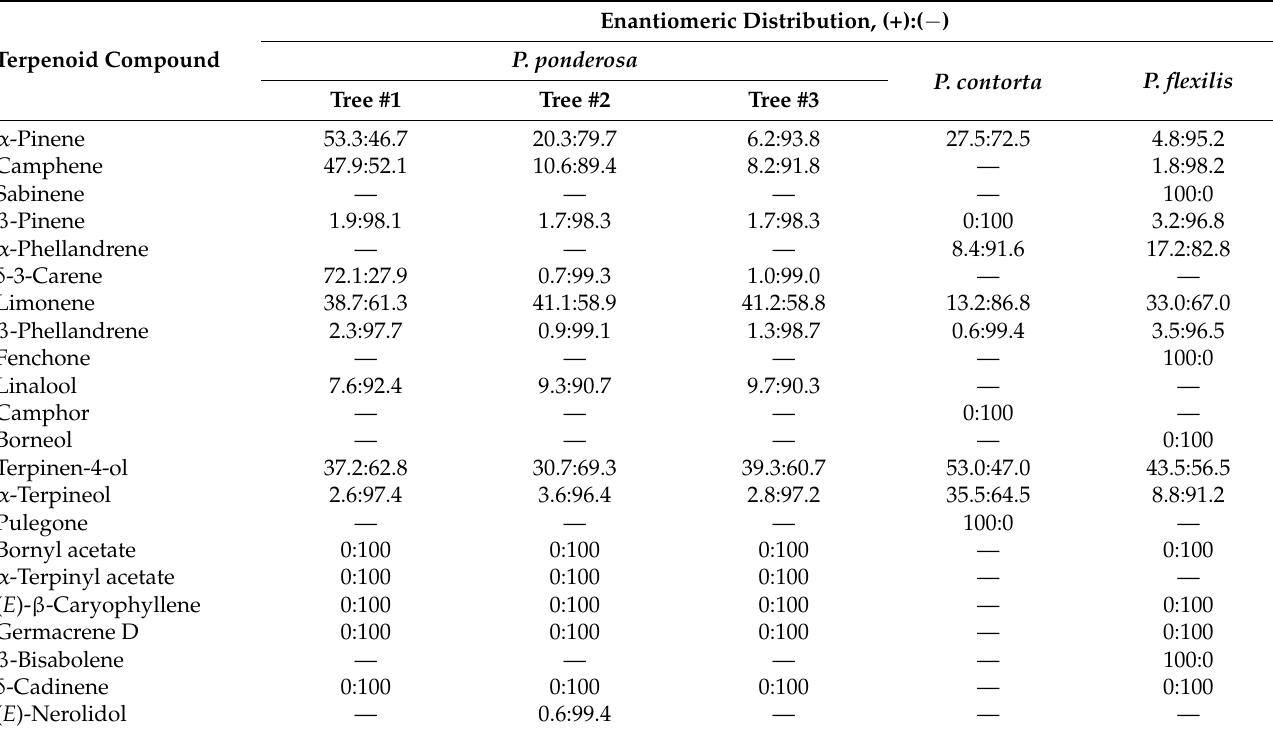
Table 4. Enantiomeric distribution of terpenoids of Pinus ponderosa var. ponderosa , Pinus contorta subsp. contorta , and Pinus flexilis leaf essential oils.